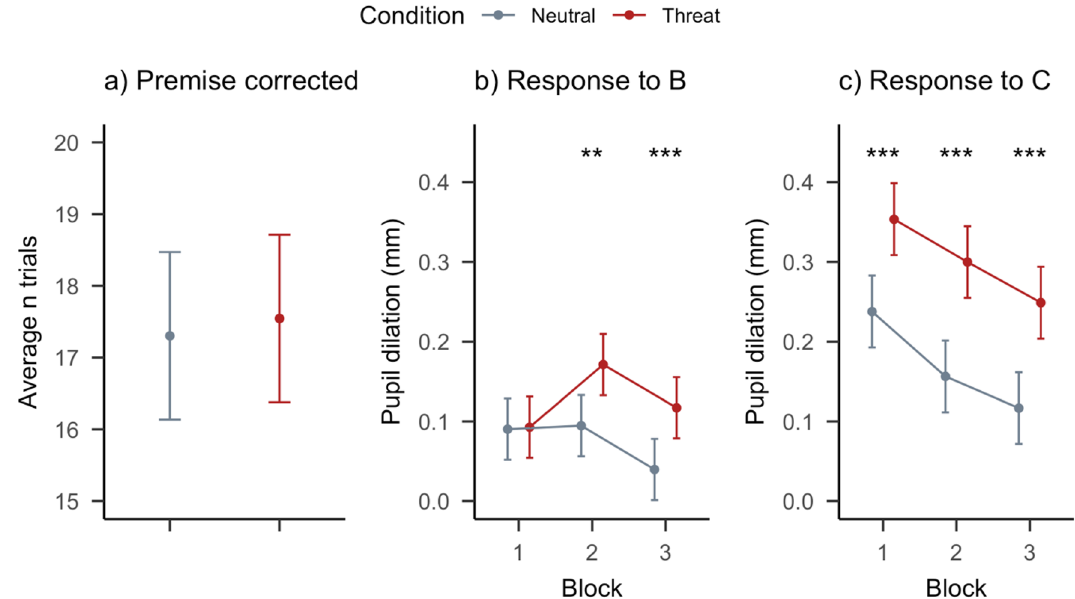
Figure 2. Analyses to validate the novel PRE-Memory paradigm. ( a ) In total, participants correctly remembered both premise memories for an average of 34.85 out of 40 associative inference trials. These were divided equally across conditions. ( b ) Pupil responses to neutral B stimuli that predicted an aversive or neutral C stimulus did not differ initially in block 1, but diverged after the predictive associations were learned over the course of blocks 2 and 3, indicating successful threat acquisition. ( c ) Pupil responses to the aversive C stimuli did not habituate—they remained consistently higher than the neutral ones throughout the experiment, even though pupil responsiveness gradually decreased over learning blocks. Error bars represent 95% confidence intervals. Asterisks indicate statistically significant differences between conditions (* p < 0.05, ** p < 0.01, and *** p <